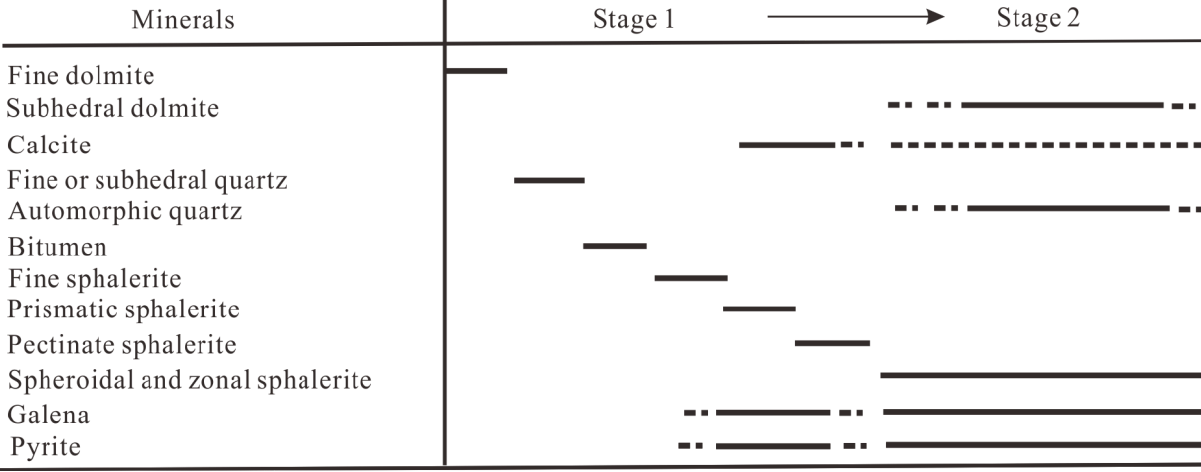
Figure 4. Schematic summary of mineral paragenesis in the Wusihe deposit. The sphalerite that formed in the early stage of mineralization is characterized by fine grains, dentate and comb shapes, and limited inclusions. In some cavities, fine-grained sphalerite aggregates (Sp 11 ), dentate sphalerite (Sp 12 ), and comb-shaped sphalerite (Sp 13 ) are filled in turn from the edge to the center of the cavities (Figure 5a). The sphalerite (Sp 2 ) formed in the late stage is mostly spherical, with particles ranging from 3 mm–2 cm, most of them having a concentric banded structure (Figures 3e,g and 5f), and some bitumen and few host rocks are encapsulated in the sphalerite (Sp 2 ). Early-formed minerals, such as fine-grained sphalerite (Sp 11 ) (Figure 5b) and galena (Ga 1 ) (Figure 5e), and host rocks, such as bituminous dolomite (Figure 5c), pore fillings with bitumen (Bit 1 , Bit 2 ) (Figure 5d) and siltstone (Figure 5c), were encapsulated in late sphalerite (Sp 2 ), indicating that the late sphalerite (Sp 2 ) was formed in different periods after the thermally cracked bitumen. Two distinct generations of galena can be identified: early galena is encapsulated in sphalerite (Sp 2 ) (Figure 5e), and late galena is paragenetic with late sphalerite (Sp 2 ) (Figure 5f). Some- times, thermally cracked bitumen inclusions (Bit 1 ) can be observed in the late galena (Ga 2 ), indicating that they formed later than thermally cracked bitumen. Two stages of gangue minerals, such as dolomite, calcite, and quartz, can be identified. The early dolomites (Dol 1 ) are distributed in granular form at the edges of the pores, and the bitumen is attached to the early dolomite, forming a ring shape (Figure 5g). The late dolomites (Dol 2 ) are mostly euhedral–subhedral and closely paragenetic with the late bitumen (Bit 2 ), sphalerite (Sp 2 ), and quartz (Q 2 ) (Figures 3e and 5g). The early quartz (Q 1 ) is distributed in the edges of pores in fine grain, and the relict pore spaces are filled with bitumen (Figures 3d,f and 5h). The late quartz (Q 2 ) is mostly euhedral and conical, and it is paragenetic with late bitumen (Bit 2 ), sphalerite (Sp 2 ), and dolomites (Dol 2 ) (Figures 3f and 5g,h). They are character- ized by enrichment in single-phase hydrocarbon inclusions [29] and bitumen inclusions (Figure 5h,i). The abundant bitumen inclusions in the late quartz (Q 2 ) indicate that they formed after the thermally cracked bitumen (Bit 1